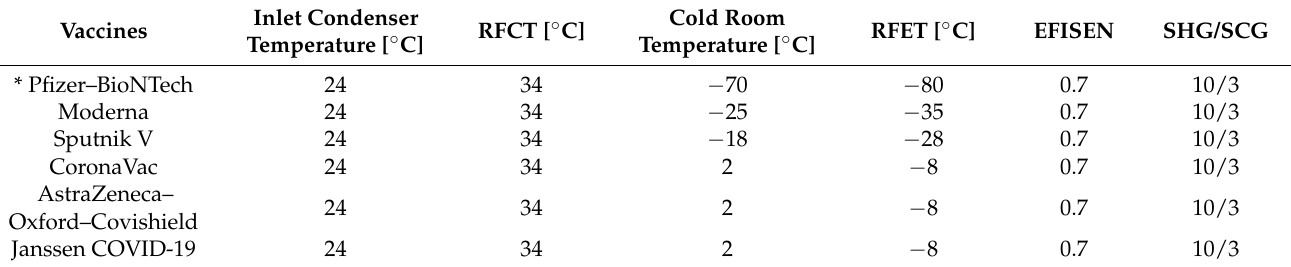
Table 4. Equipment characteristics according to the vaccine brand.